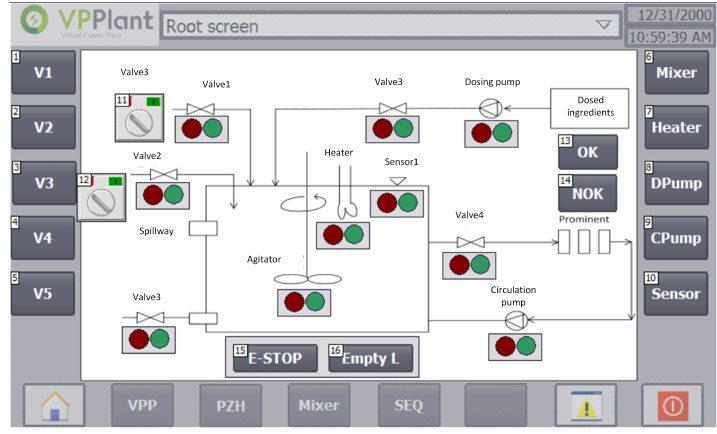
Figure 10. VPP screen—Application control and device status monitoring